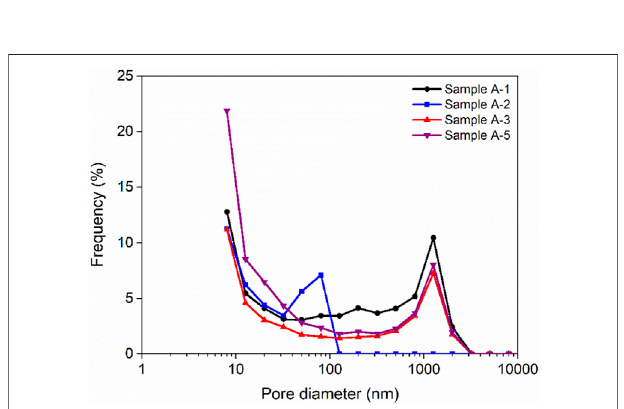
FIGURE 7 | Pore size distribution of representative shale samples from well Anye A well platform derived from capillary pressure curves.